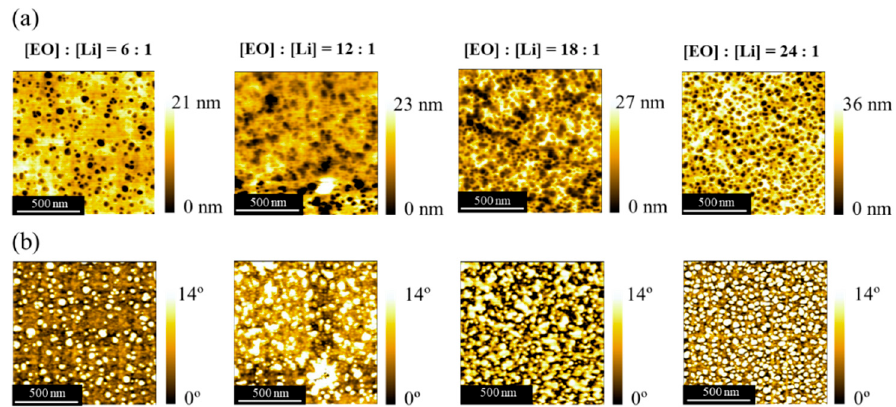
Figure 3. AFM ( a ) height and ( b ) phase images of PPEGMA 68 - b -SPB 121 /LiTFSA